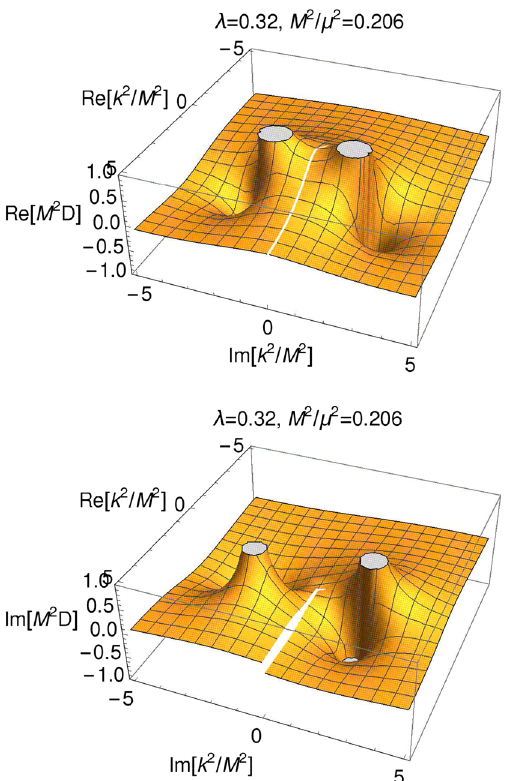
Fig. 16 Thegluonpropagator D ( k 2 ) asacomplexfunctionofthecom- plex squared momentum k 2 ∈ C , (top) the real part Re D ( k 2 ) , (bottom) the imaginary part Im D ( k 2 ) , at the physical point of the parameters λ := Ng 2 /( 4 π) 2 = 0 . 32, M 2 /μ 2 = 0 .